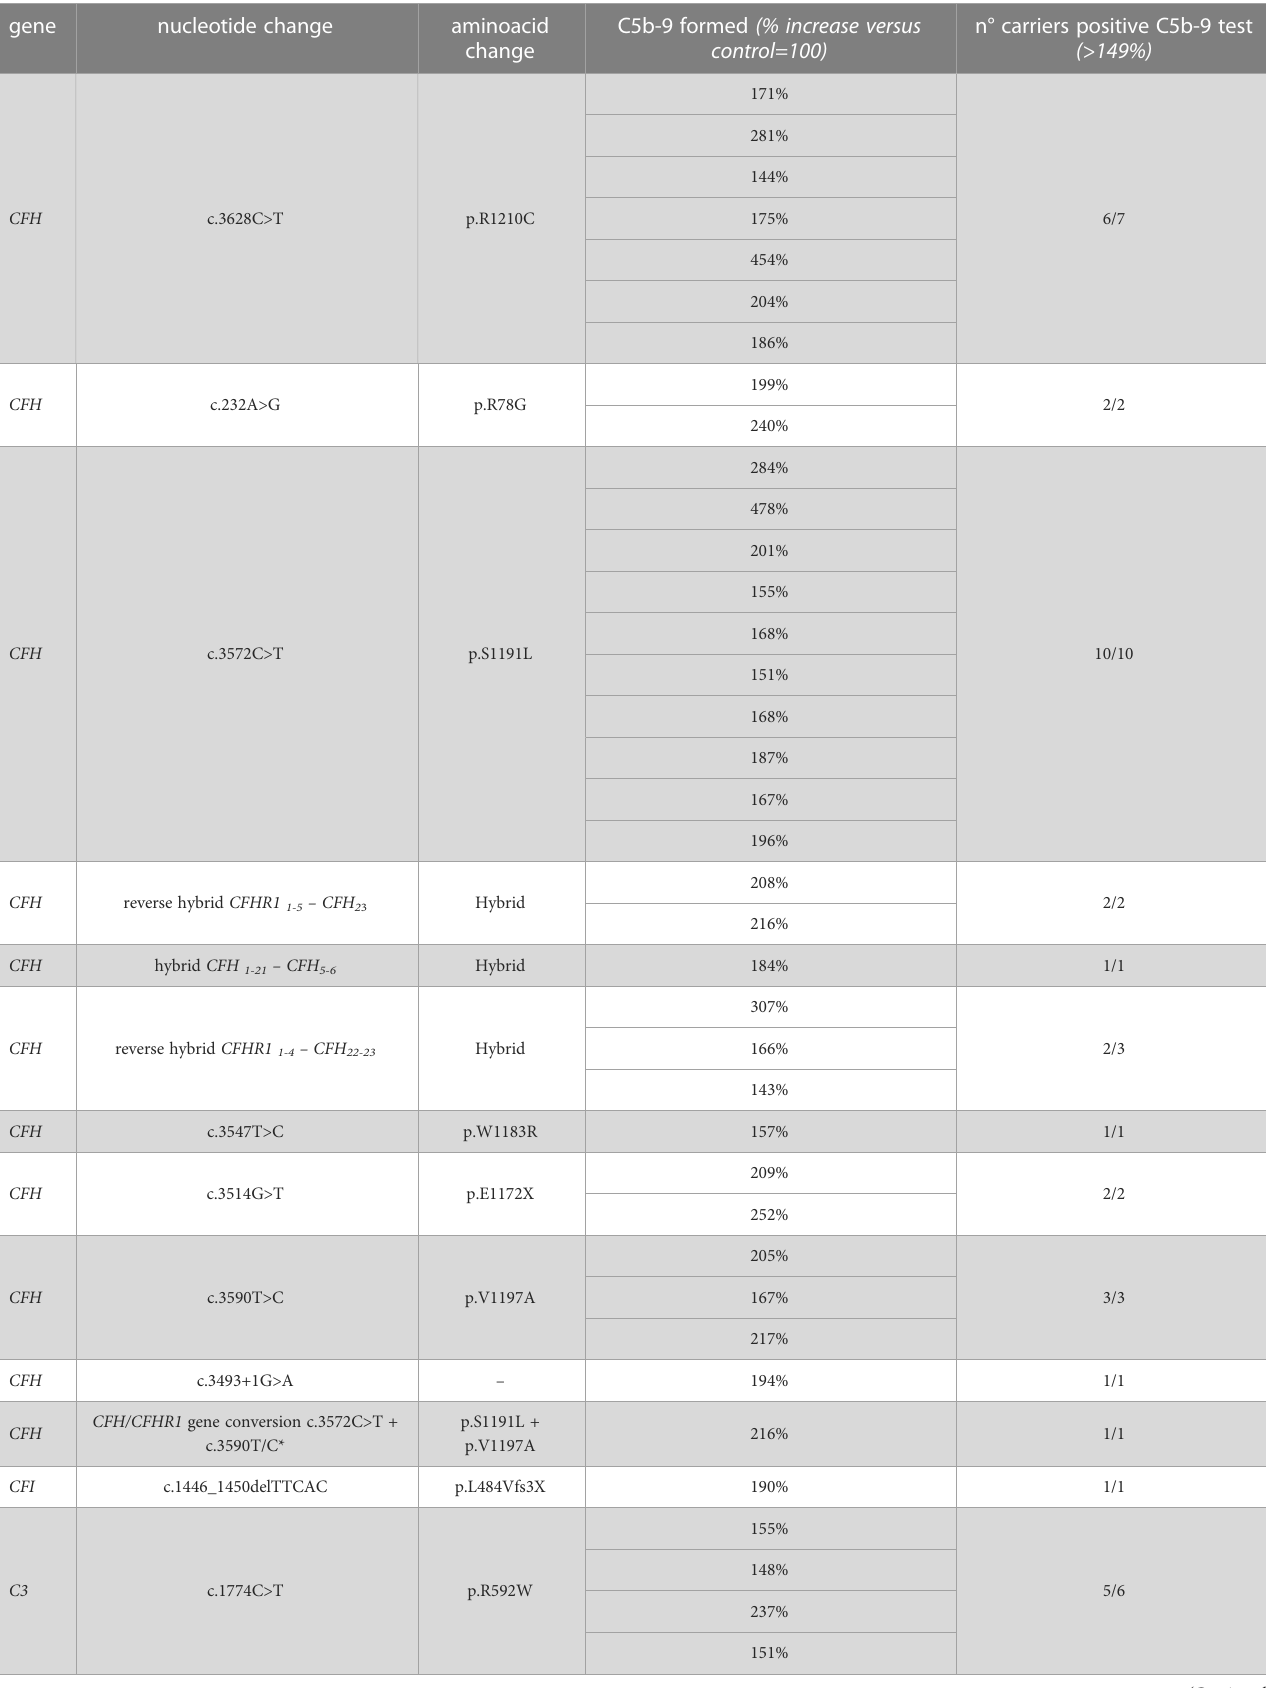
TABLE 3 Results of C5b-9 test in unaffected family members who carry PV in genes encoding fl uid phase proteins that segregate with the disease.